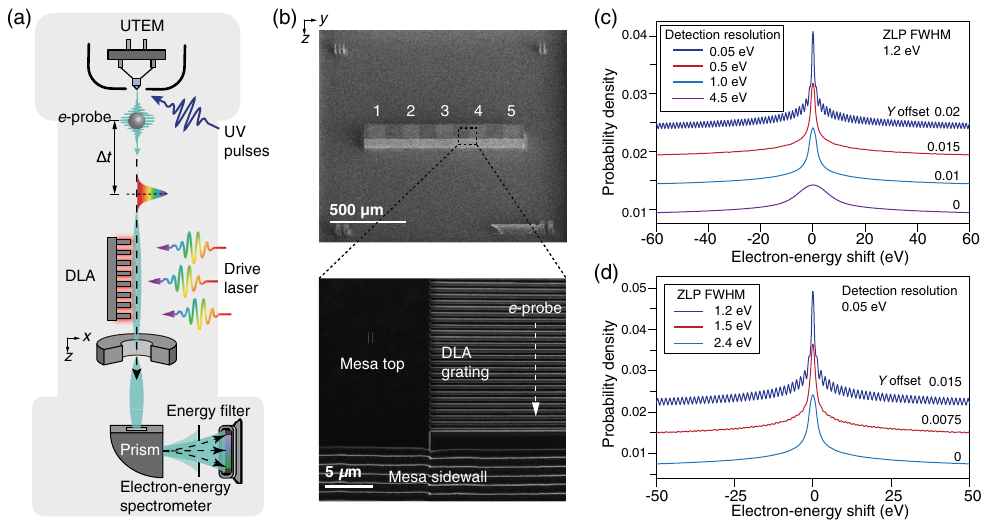
FIG. 1. Study of DLA in the UTEM. (a) A schematic of the UTEM and its special mode of operation providing the platform to study electron acceleration. (b) Scanning-electron-microscopy image of the DLA structure in our experiment. This DLA is a one-sided silicon- based grating with a period of 655 nm, teeth height of 195 nm, 45% duty cycle, and a total length of 89 μ m designed to mediate the interaction between a 950-nm laser pulse and a 195-keVelectron pulse. The top panel depicts a set of five similar gratings separated by a flat mesa square formed for alignment convenience; below is an enlargement of the border between such a grating and a flat mesa area. (c) Quantum theory of the electron-energy spectrum after DLA interaction, calculated with four different detection resolutions. The resolution of 4.5 eV is the best that was used in DLA experiments till now [17], to the best of our knowledge, and it is not sufficient for probing the quantum nature of the interaction. The three other resolutions of 1, 0.5, and 0.05 eVare available in state-of-the-art electron spectrometers in electron microscopes and used in the UTEM setup in this work. Yet, only the finer resolution among them is sufficient to unveil quantum features in the spectrum (for the given parameters), as we also see experimentally below. (d) Theoretical electron- energy spectrum after DLA interaction calculated with three different initial energy spreads of the electron beam. The quantum nature of the interaction is revealed only for an electron beam that is highly coherent (approximately